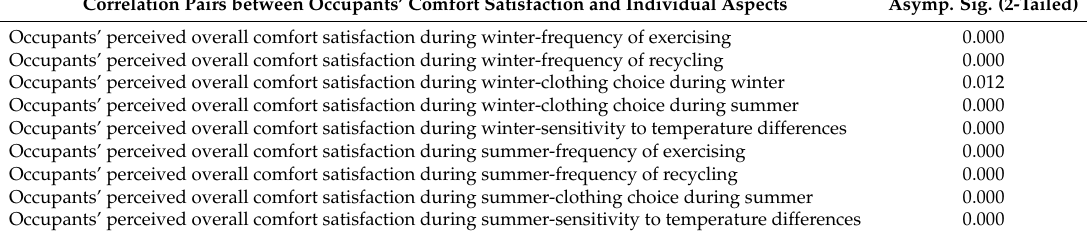
Table 7. Results of Wilcoxon analysis regarding correlations among occupants’ comfort perception and social